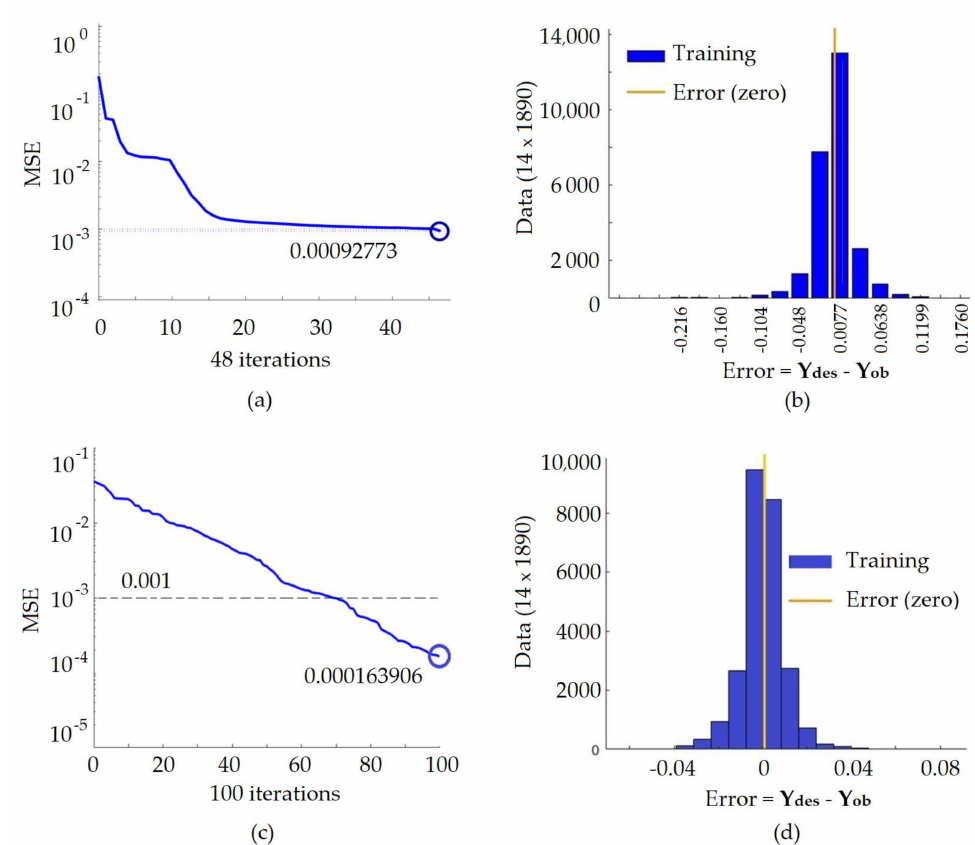
Figure 4. ANN performance; ( a ) training performance (MSE) of the MLP network, ( b ) error his- togram ( Y des − Y ob ) for the MLP network with 20 intervals for the 1890 output samples, ( c ) training performance (MSE) of the RBF network, ( d ) error histogram ( Y des − Y ob ) for the RBF network with 20 intervals for the 1890 output